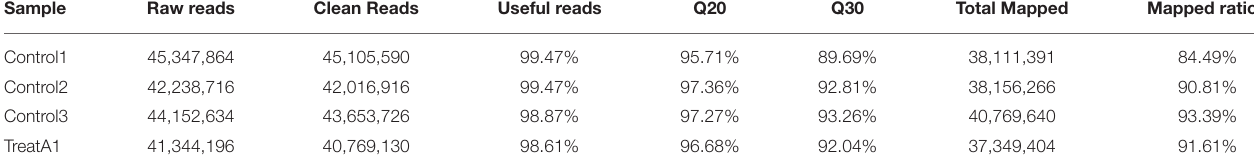
TABLE 2 | Statistical analysis of the RNAs Libraries.